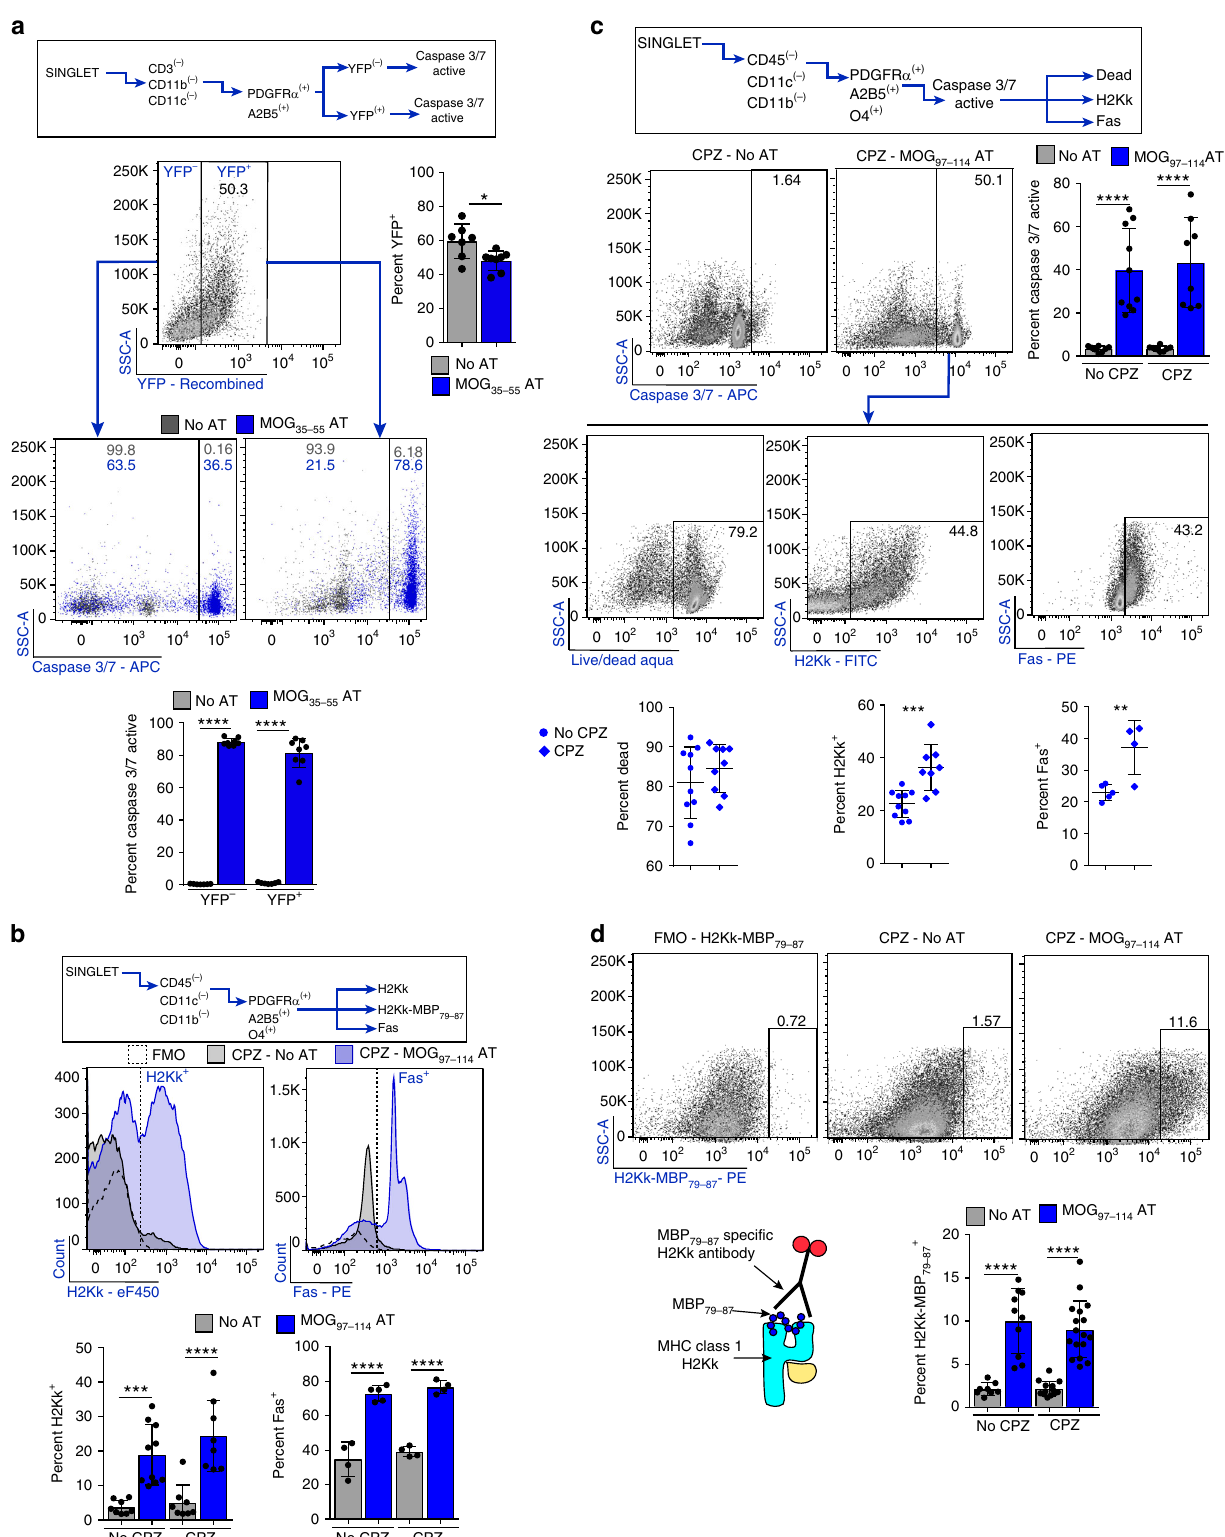
to 30% sucrose for 3 days, cryosectioned (30 μ m) and kept in antifreeze, and stored in at − 20 °C until staining was performed. Black Gold II (Millipore) was used to determine myelin content in the corpus callosum. Sections at ~ − 0.5 mm, − 1.0 mm, and − 2.0 mm posterior to bregma were stained with α -mouse- MBP SMI-99 (1:1000; eBioscience) and α -rabbit-CD3 (1:50; GeneTex) to determine myelin staining and lymphocyte in fi ltration, respectively. Lymphocyte